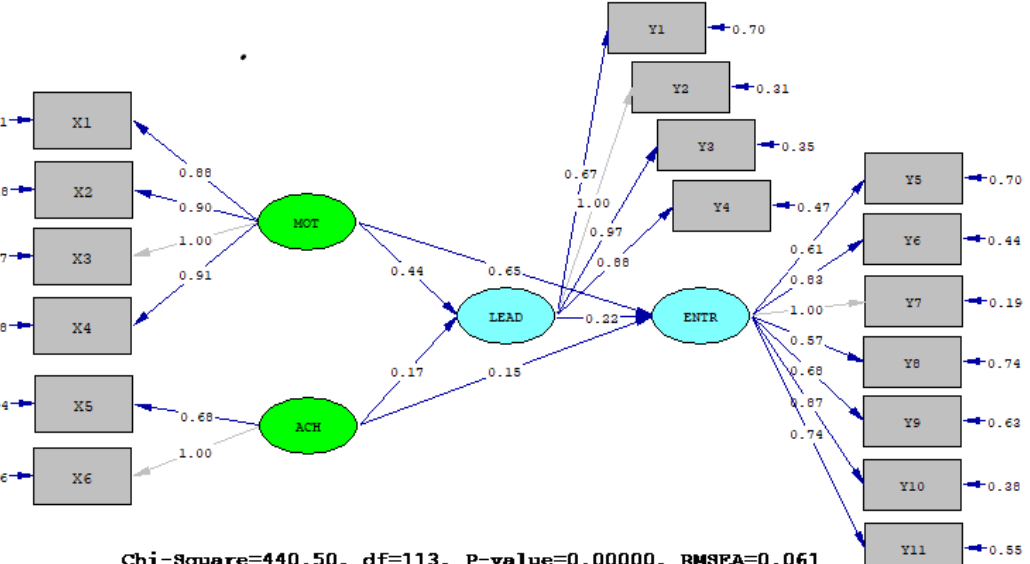
Figure 4. Structural effects of achievement motivation, achievement, leadership, and student entre- preneurial spirit. MOT = Achievement Motivation. ACH = Achievement. LEAD = Leadership. ENTR = Entrepreunership